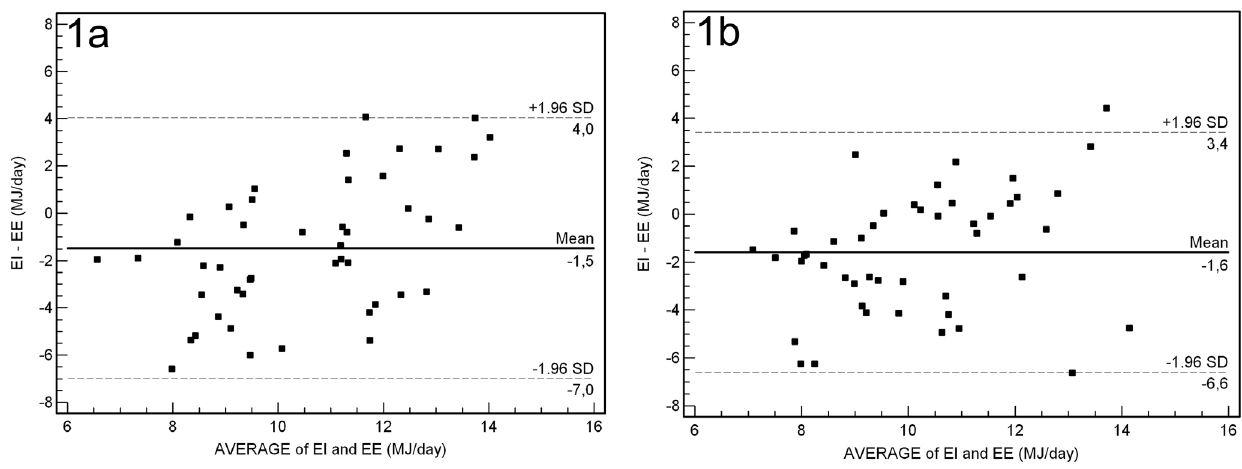
Figure 1. Bland - Altman plots: the baseline difference (Fig.1a) and post-test difference (Fig.1b) between estimated energy expenditure (EE) and estimated energy intake (EI) plotted against the mean of EE and EI. The solid line represents the mean, and the dotted line represents the limits of agreement (plus or minus 1.96 SD).